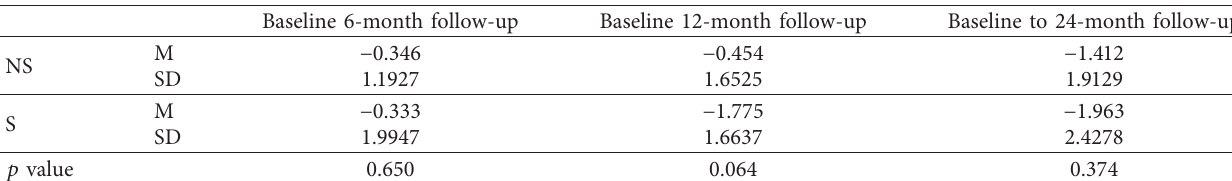
Table 4: The mean � M and standard deviation � SD for the nonsubmerged � NS and submerged � S groups of patients for the ball at- tachment group. p value ≤ 0.05 is considered statistically significant ( ∗ ).